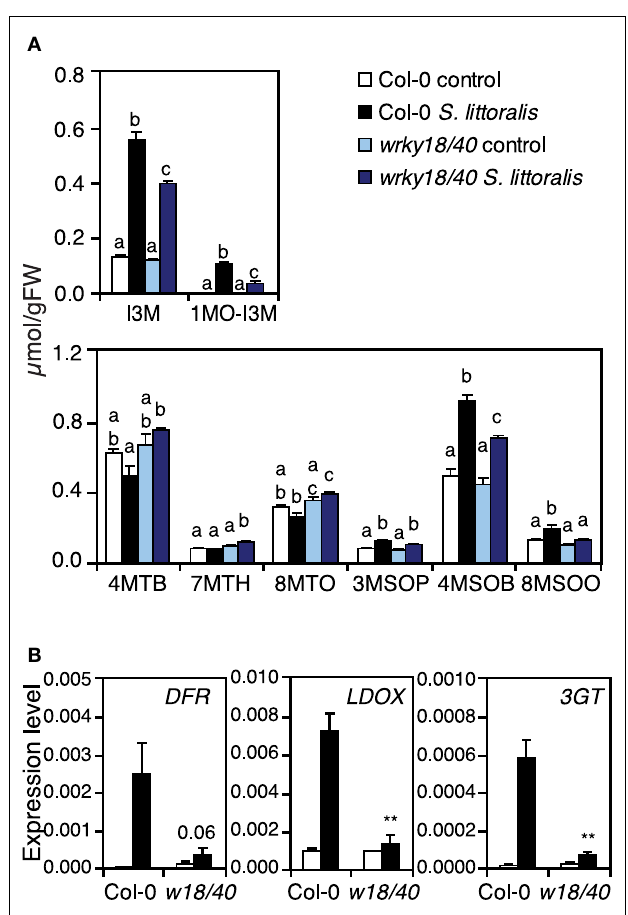
FIGURE 5 | Quantification of glucosinolates and expression of phenylpropanoid pathway genes in wrky18wrky40 mutant. (A) Levels of eight glucosinolates were quantified in Col-0 and wrky18wrky40 double mutant. Plants were challenged for 2days with S. littoralis larvae. Unchallenged plants were used as controls.Values are the mean ( ± SE) of four biological replicates. Bars with different letters differ at P < 0.05 (Tukey’s HSD test). 4MTB, 4-Methylthiobutyl-GS; 7MTH, 7-Methylthioheptyl-GS; 8MTO, 8-Methylthiooctyl-GS; 3MSOP, 3-Methylsulfinylpropyl-GS; 4MSOB, 4-Methylsulfinylbutyl-GS; 8MSOO, 8-Methylsulfinyloctyl-GS; I3M, Indol-3-ylmethyl-GS; 1MO-I3M, 1-Methoxyindol-3-ylmethyl-GS. (B) The wrky18wrky40 mutant shows altered expression of phenylpropanoid pathway genes DFR , LDOX , and 3GT in response to herbivory. Relative expression was measured by qRT-PCR in untreated plants (white bars) and in plants challenged for 48h with S. littoralis larvae (black bars).Values are the mean ( ± SE) of three replicate experiments. Asterisks indicate statistically significant differences in treated wrky18wrky40 plants compared to treated Col-0 plants (Student’s t -test, * P < 0.05, ** P < 0.01, *** P < 0.001).